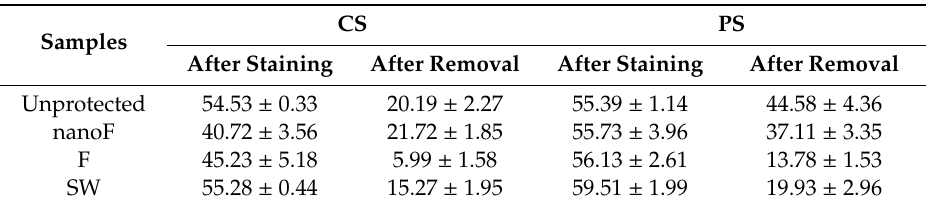
Table 3. Global color difference ( Δ E * ab ) determined after the staining by spray paint and after the cleaning. For each data set the standard deviation is reported.